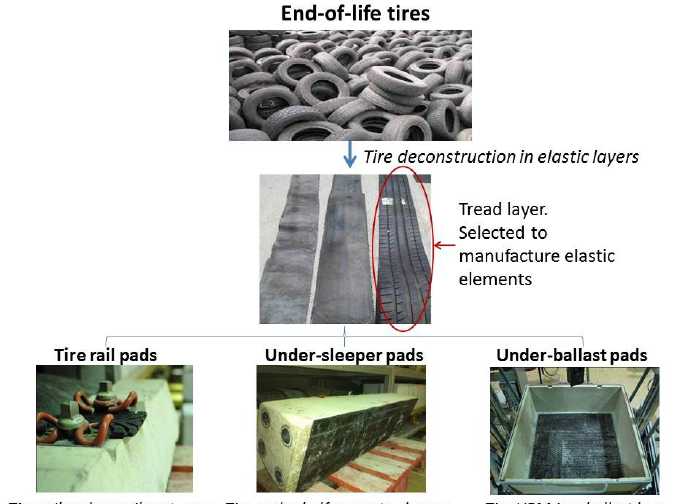
Figure 1. Manufacturing process of different tire elements for railway tracks.